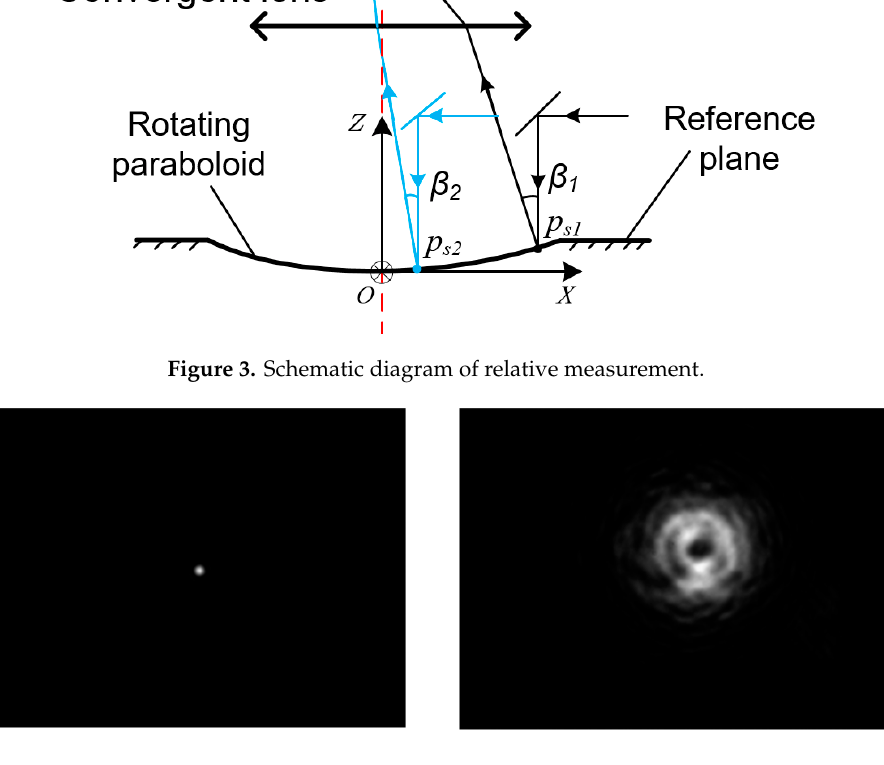
Figure 3. Schematic diagram of relative measurement.